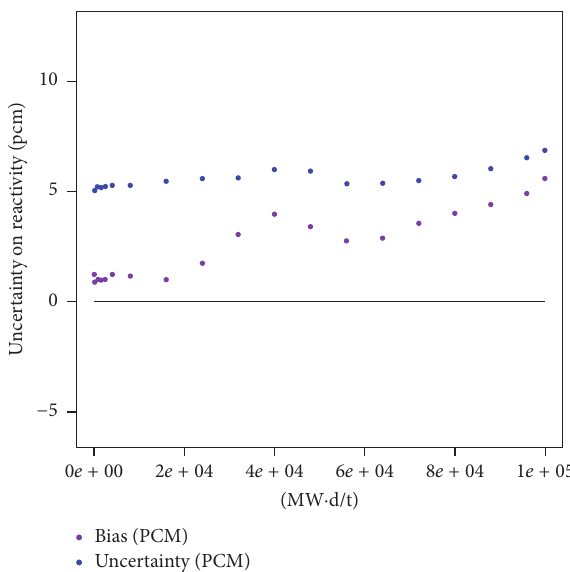
Figure 3: Uncertainty on reactivity (pcm) induced by PTh.